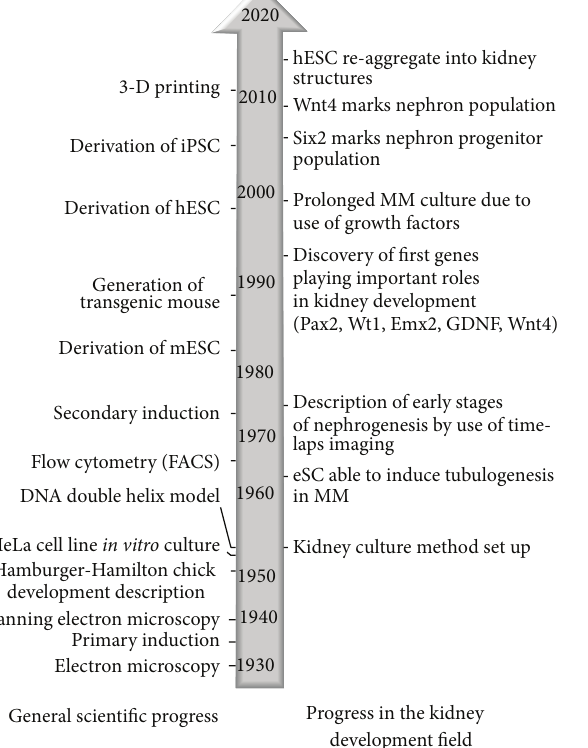
Figure 2: Relation between technology development and scientific progress: advances in biology and medicine are limited by available analytical techniques. Therefore continued progression in the fields like microscopy, immunohistochemistry, or cell biology and especially genetics enabled other biomedical fields, such as developmental nephrology, to flourish; 3D: three dimensional, DNA: deoxyribonucleic acid, ESC: embryonic stem cells, FACS: fluorescently activated cell sorting, MM: metanephric mesenchyme, and eSC: embryonic spinal